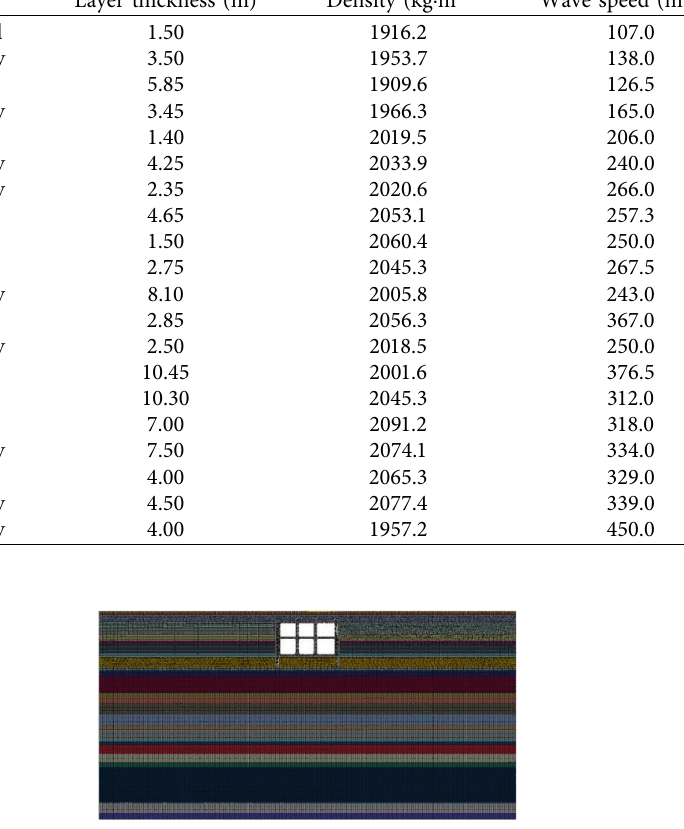
Figure 1: Finite element meshing of the formation-structure